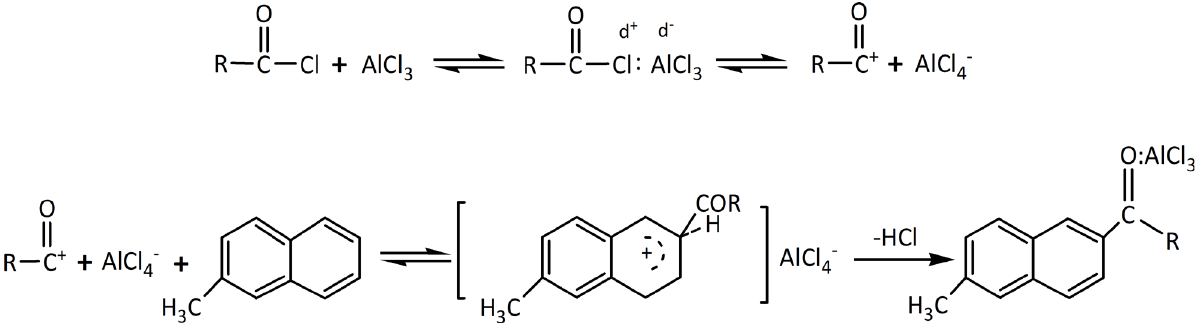
Figure 2: Mechanism of the acylation reaction of 2-MN.